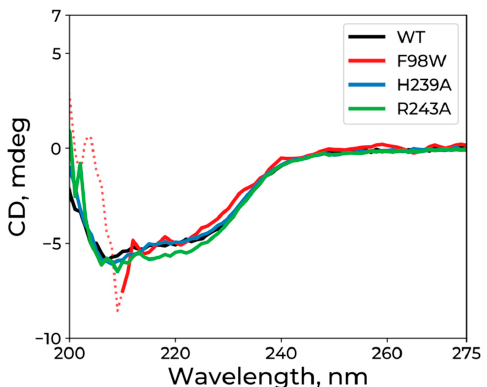
Figure 5. CD spectra of WT hSMUG1 and mutants F98W, H239A, and R243A. A high noise up to 210 nm in the spectrum of F98W (dashed curve) was due to high salt concentration in the sample (see Materials and Methods).